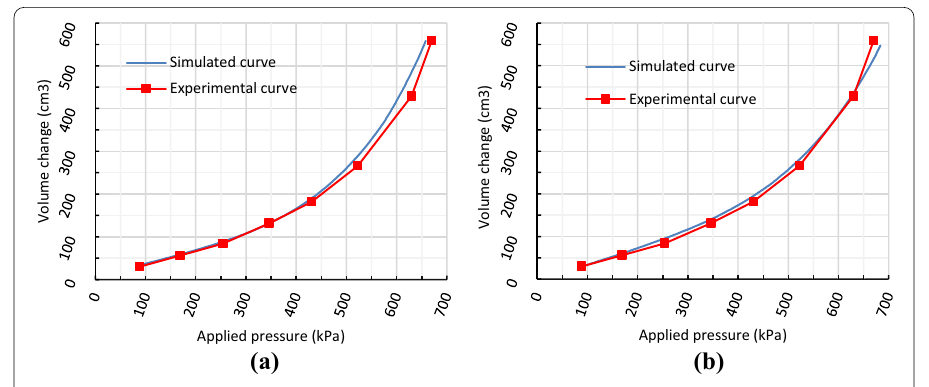
Fig. 10 Experimental against simulated curves at depth of 10.5 m, a simplex method, b curve decomposition method